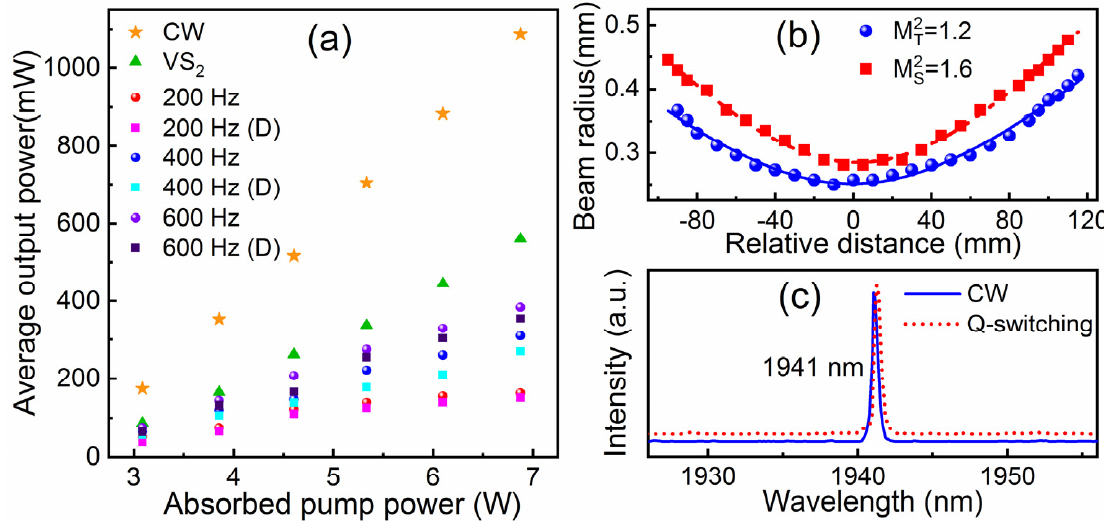
Figure 5. ( a ) Average output power, ( b ) M 2 factors, and ( c ) emission spectra of CW and Q-switched lasers. D—doubly Q-switched laser.